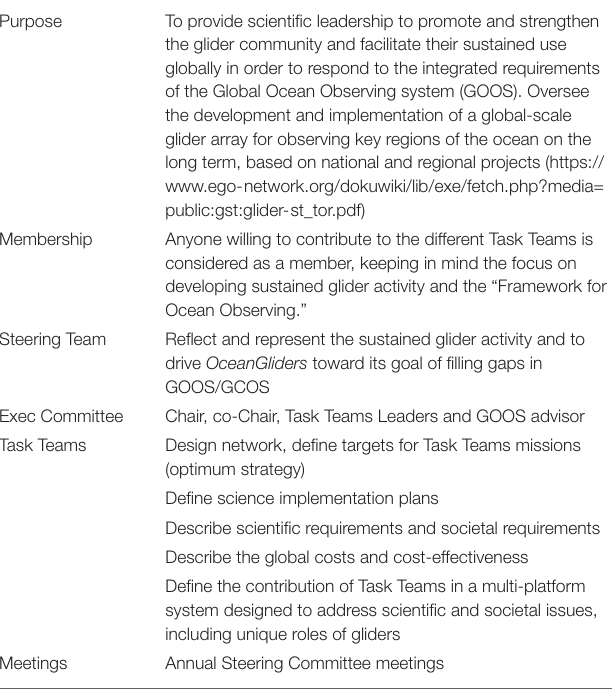
TABLE 2 | Summary of OceanGliders terms of reference and objectives.